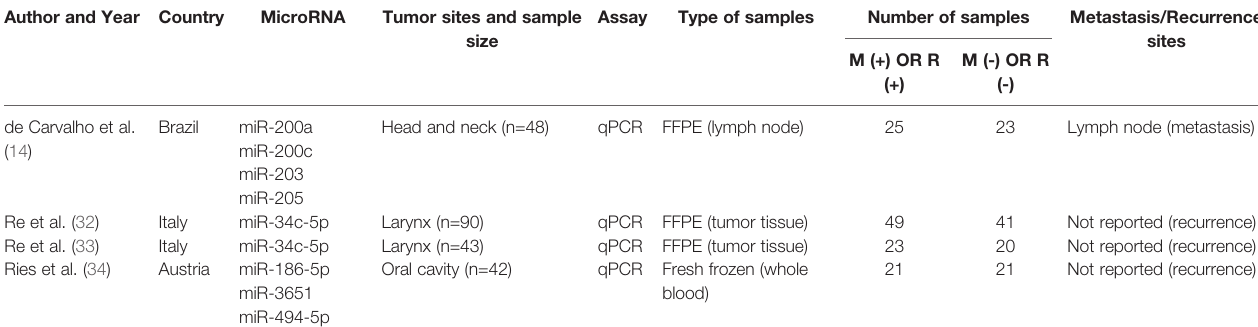
TABLE 2 | Detailed characteristics of included studies investigating diagnostic values of microRNAs for recurrence and